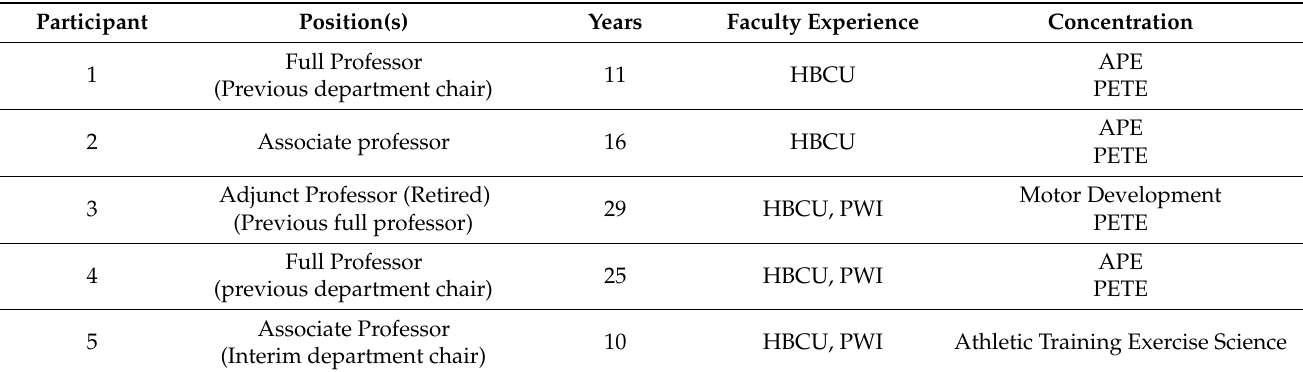
Table 1. Demographic Information of Study